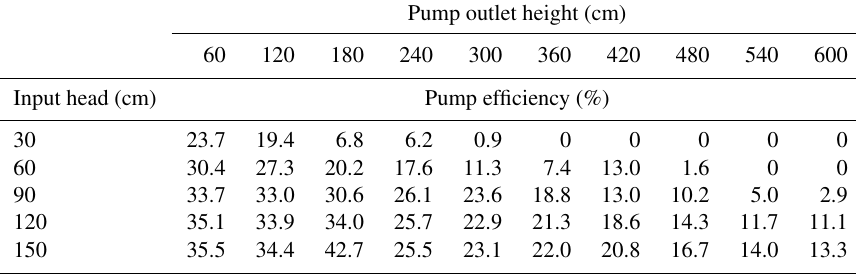
Table 4. The pump efficiency variation with input head and outlet